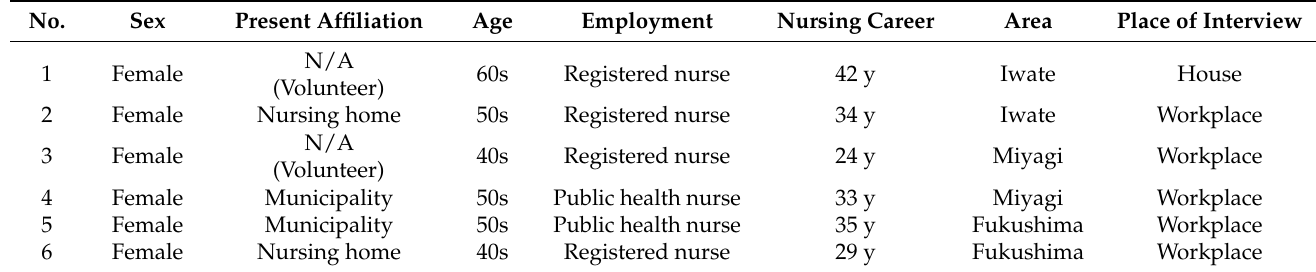
Table 1. Characteristics of the study